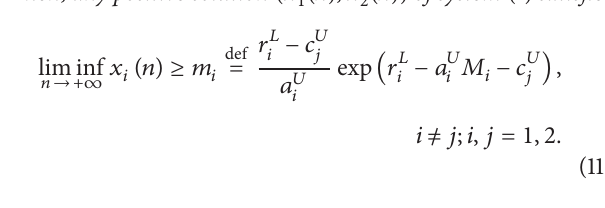
(𝑛) , 𝑥 ∗ (𝑛) , 𝑥 (𝑛) , and 𝑥 (𝑛) with the 1 2 1 2